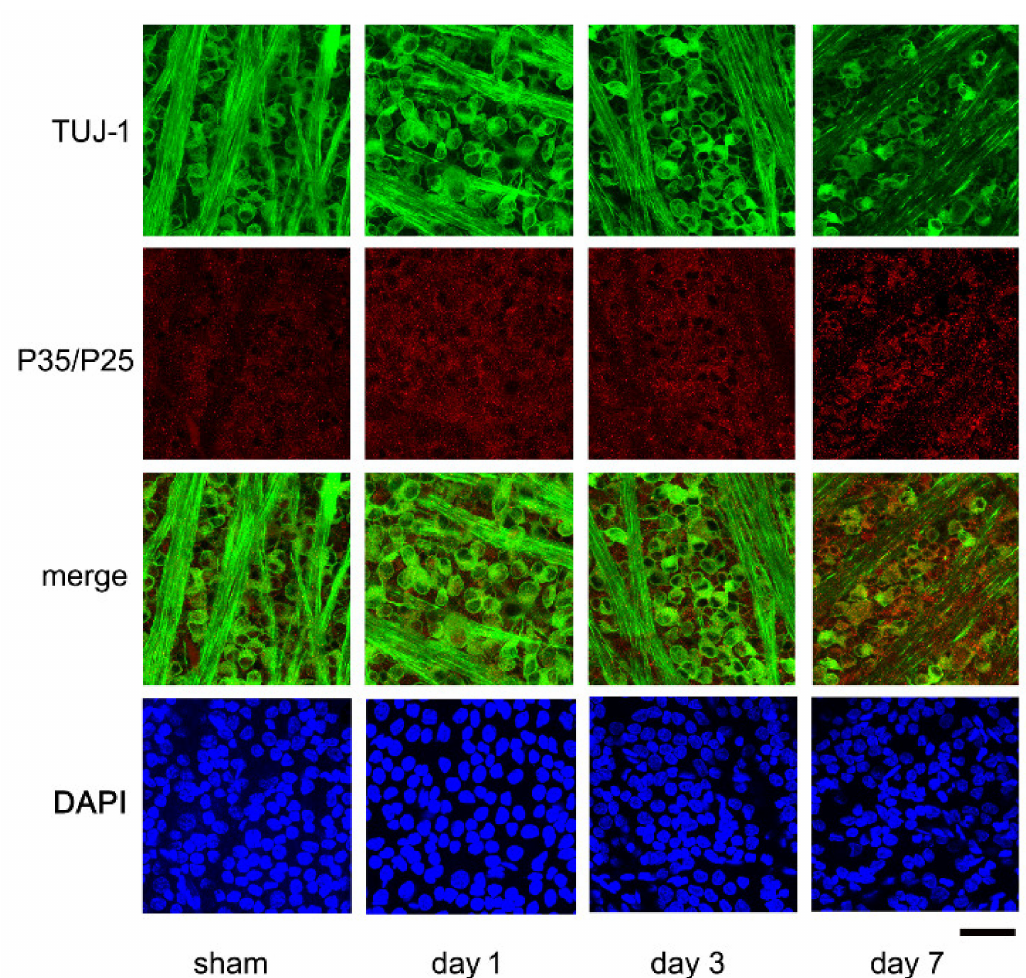
Figure 4. Representative confocal images of flat-mounted retinas demonstrating time-dependent changes in Tuj-1 and P35/P25 proteins. Tuj-1-stained cells (green), most likely RGCs, are densely packed in the sham control retina. Fine granules stained with P35/P25 (red) are distributed mainly in the somas of these cells. Retinal nerve fibers are also stained with Tuj-1. While the number of Tuj-1-stained cells seems to be stable on days 1 and 3, there are time-dependent changes in the expression of P35/P25, and the P35/P25-positive granules are coarse with increased fluorescein intensities. On day 7, the immunoreactivities to Tuj-1 in some cells are lost where P35/P25-positive granules are accumulated, suggesting pathological roles of P35/P25 proteins. (Bar = 100 µ